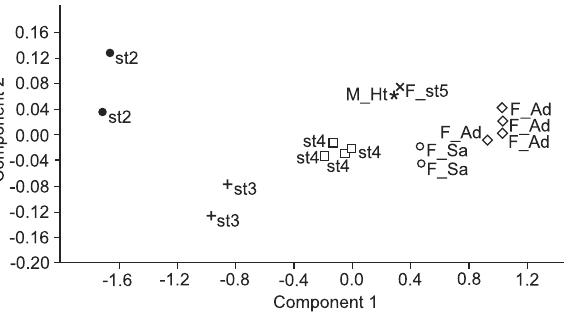
Figure 26. Ontogeny of females of Troglorhopalurus translucidus . Graphical representation of PCA showing separation by age classes. (st2) Stage 2, (st3) stage 3, (st4) stage 4, (M_Ht) male holotype, (F_st5) female stage 5, (F_Sa) female subadult, (F_Ad) female